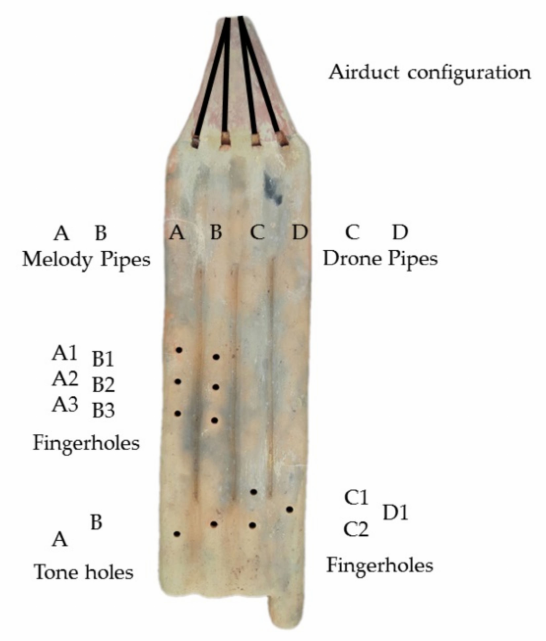
Figure 19. The organological components of a Teotihuacan quadruple flute (experimental